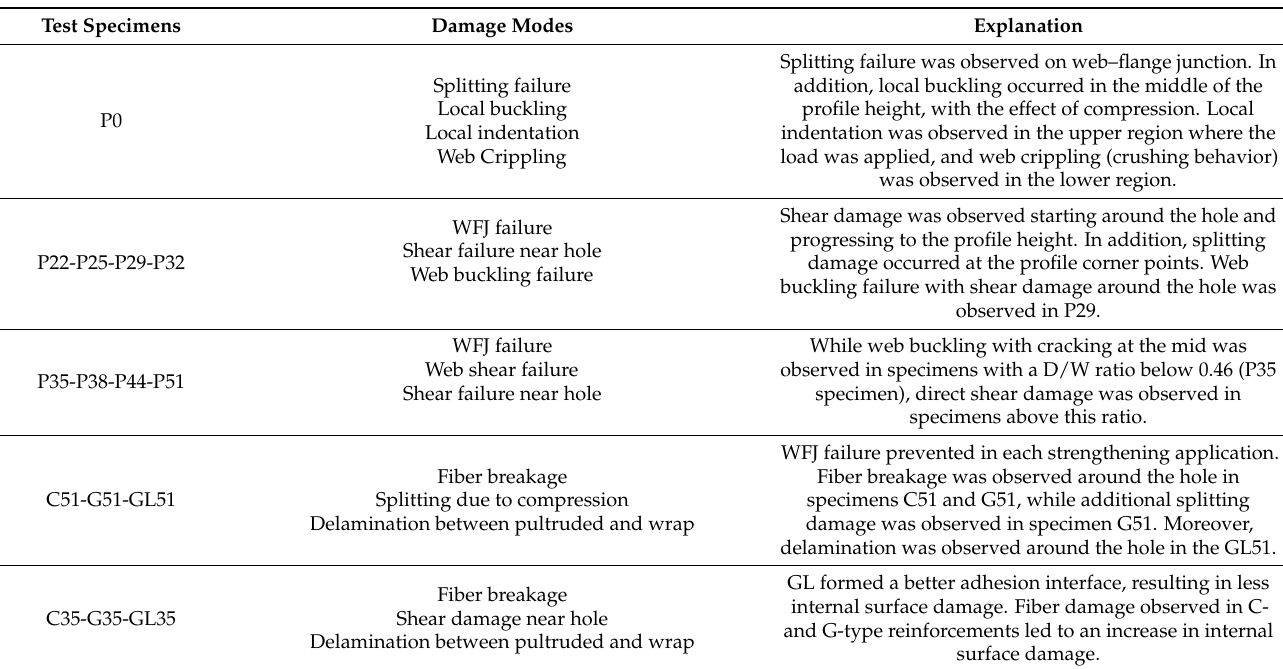
Figure 12. Normalized cross section vs. normalized capacity. Table 4. Summary of the damages observed in the experiments.